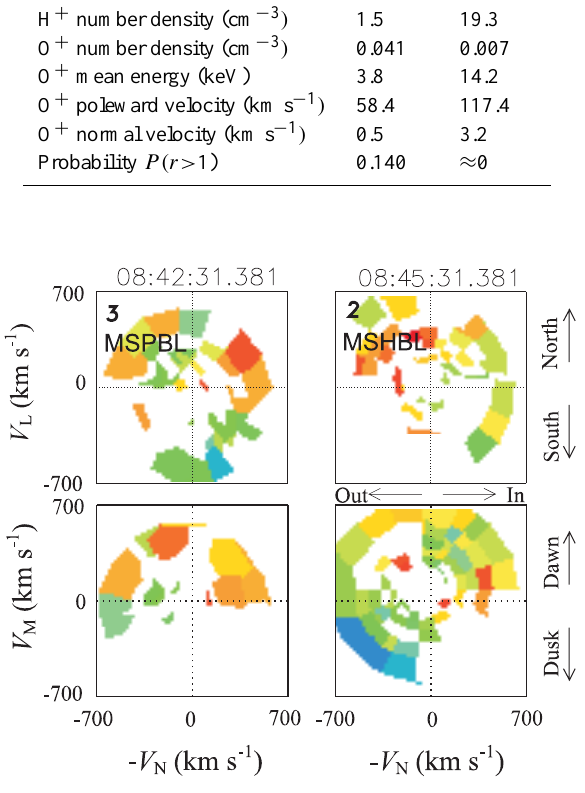
Fig. 7. From top to bottom, cutaway of the O + distribution function in the ( N , L ) plane at V M = <V M > in Log[eV/(scm 2 sreV)], in the ( N , M ) plane at V L = <V L > in Log[eV/(scm 2 sreV)]. The number in the topleft-hand side corner of each velocity distribution plot in the ( N , L ) plane refers to the region, according to Fig.